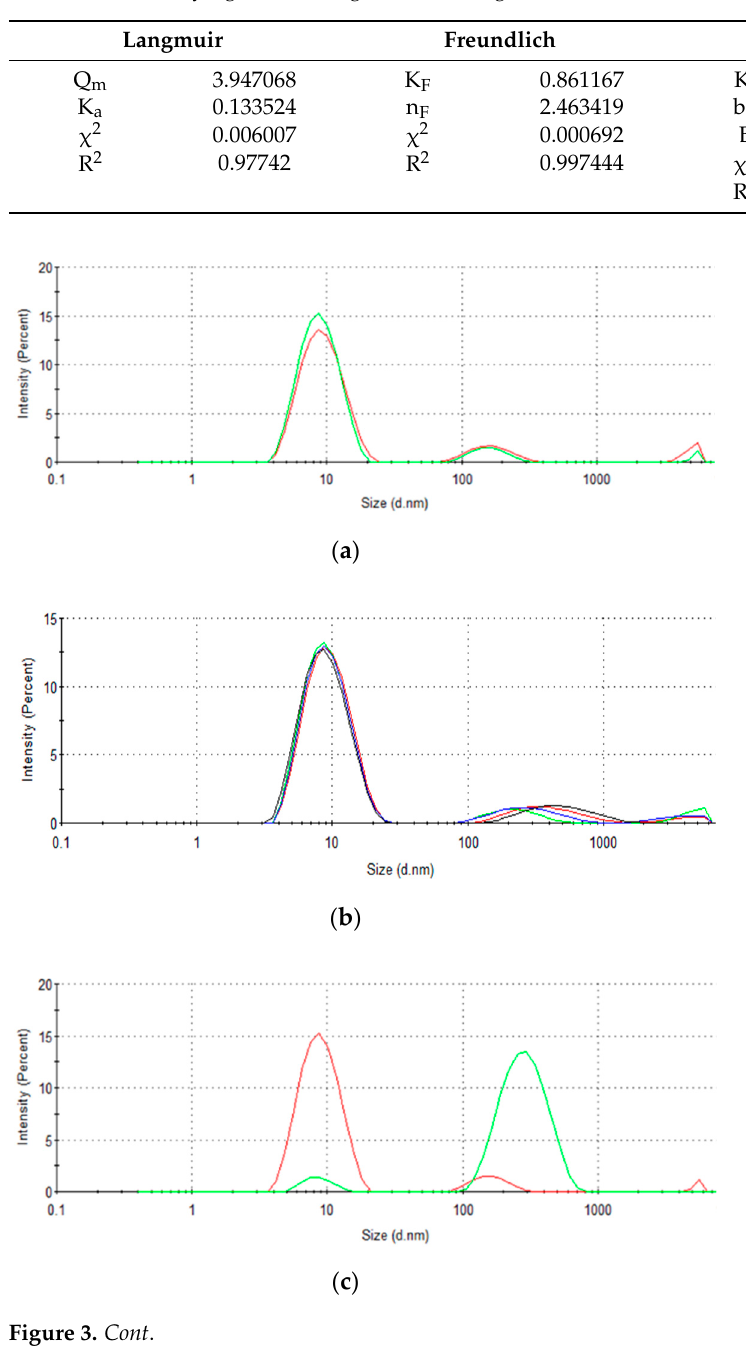
Table 2. Isotherm parameters determined through fitting of adsorption data for BSA solutions with concentrations varying from 1.5 mg·mL − 1 to 5 mg·mL − 1.